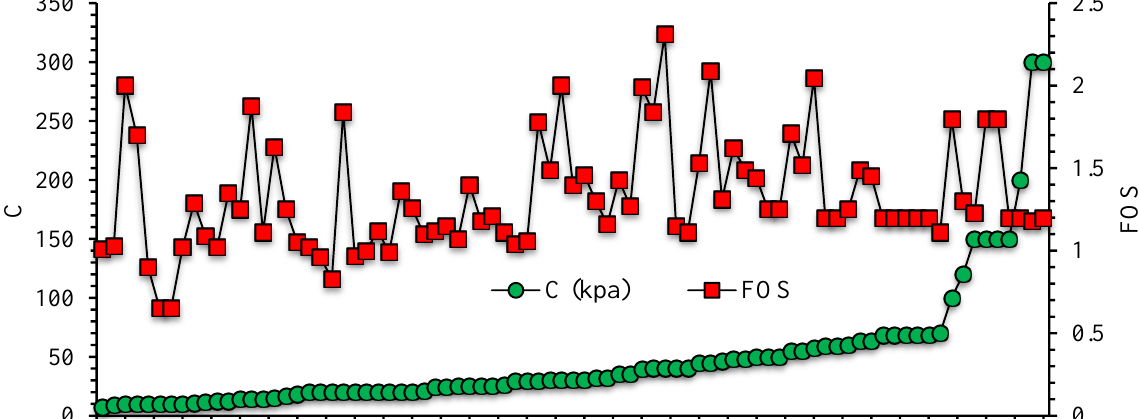
Figure 6. C-FOS changes.